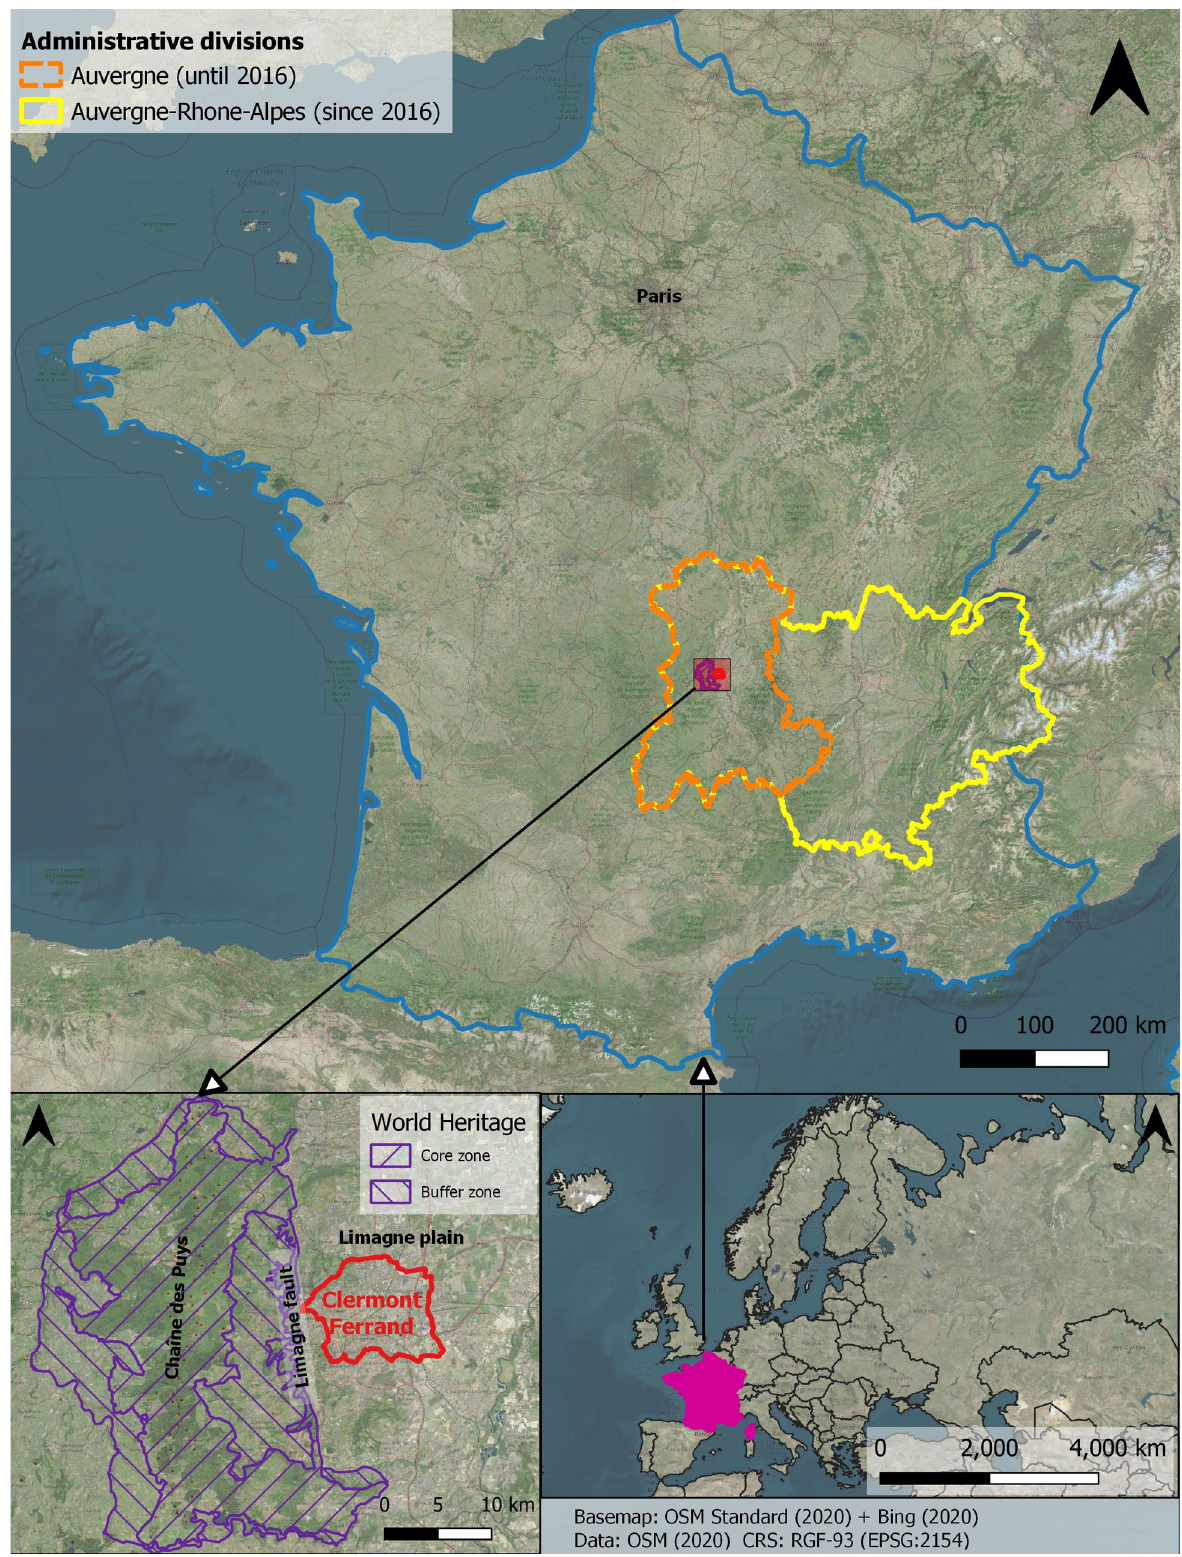
Fig. 1. The location of Clermont-Ferrand in France and in